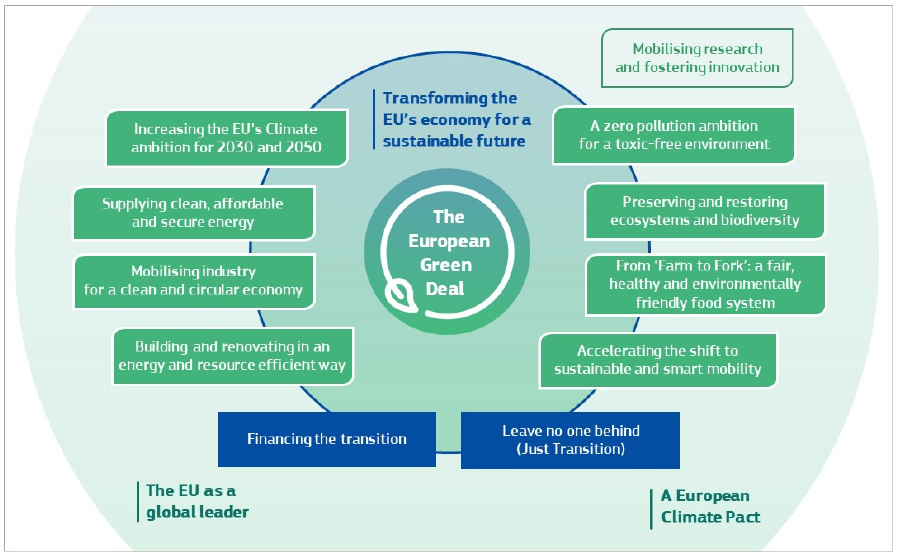
Figure 1. The European Green